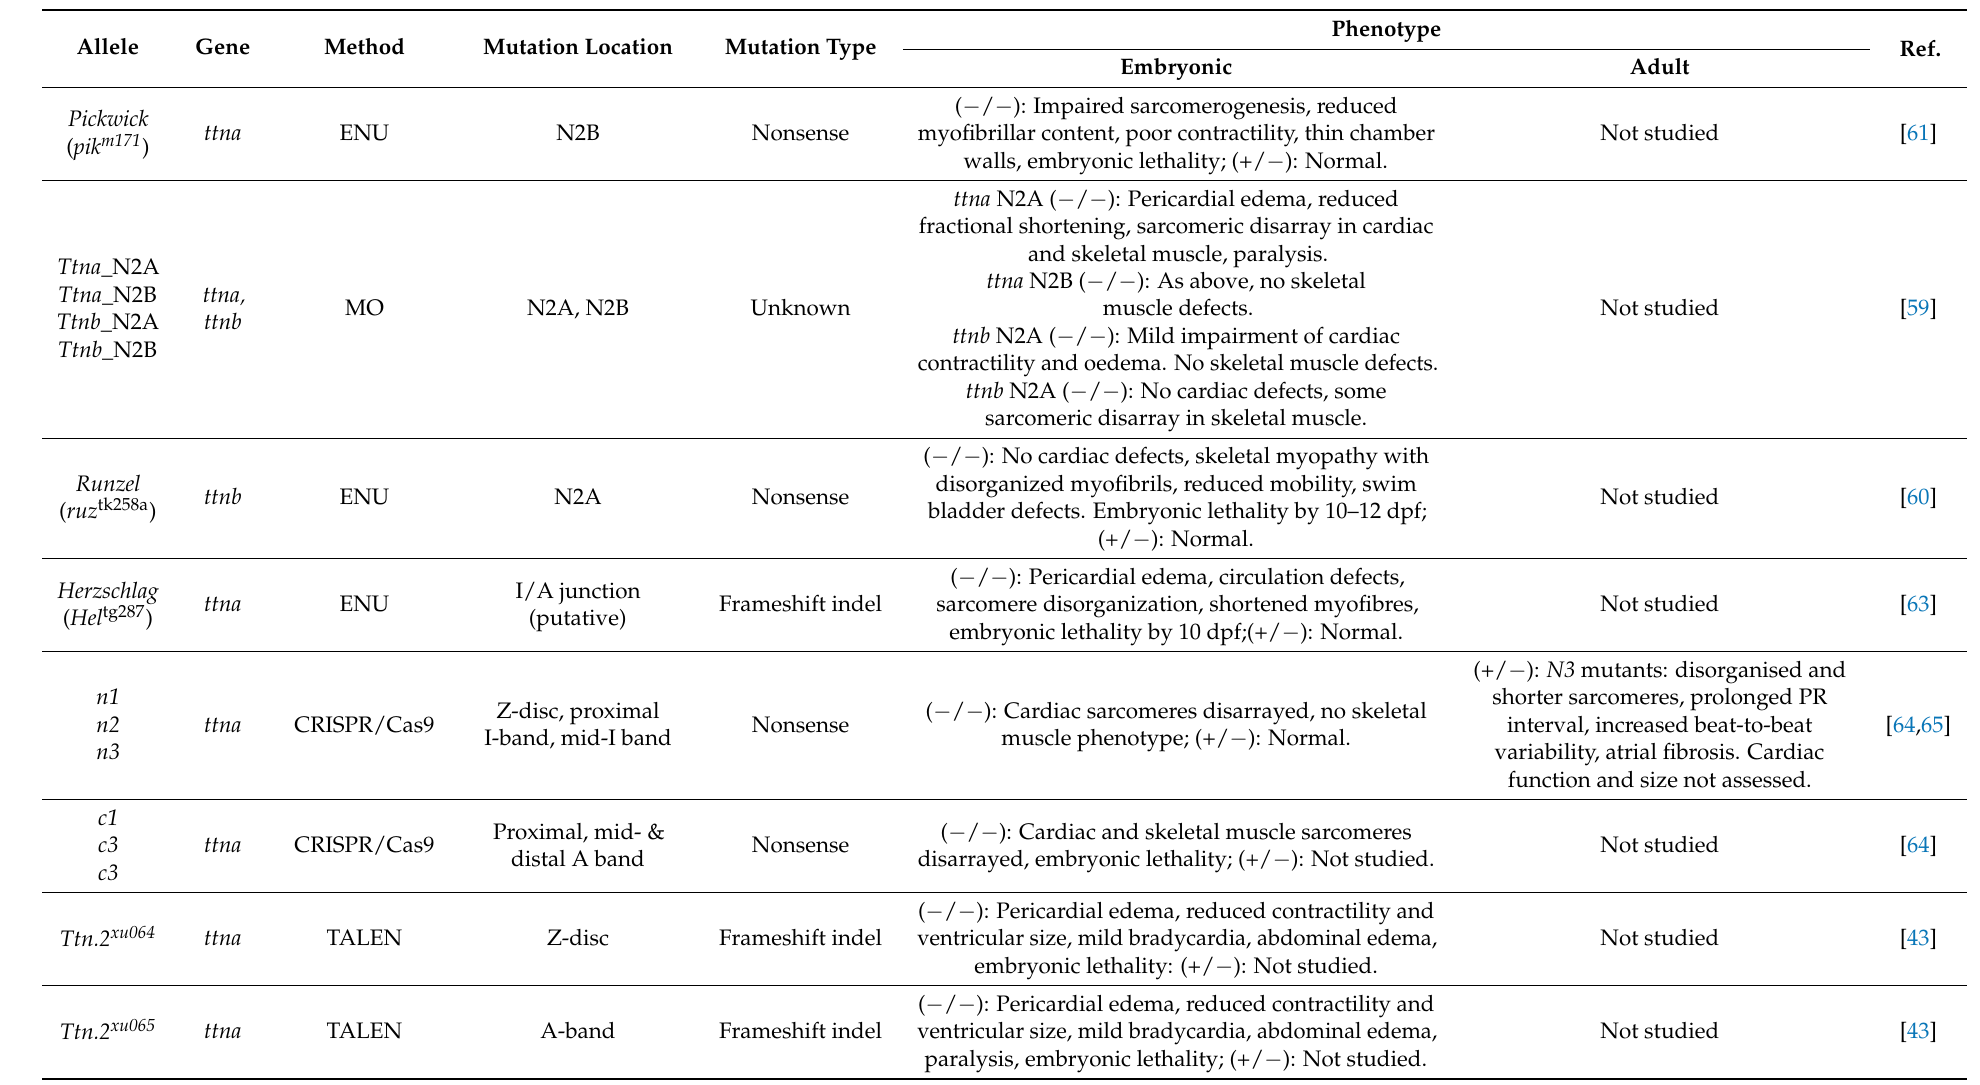
Table 1. Zebrafish models of titin